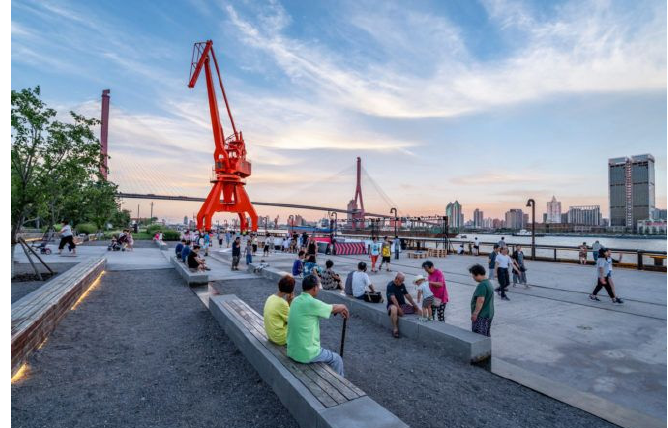
Figure 4. Phase II design of Yangpu riverside public space.